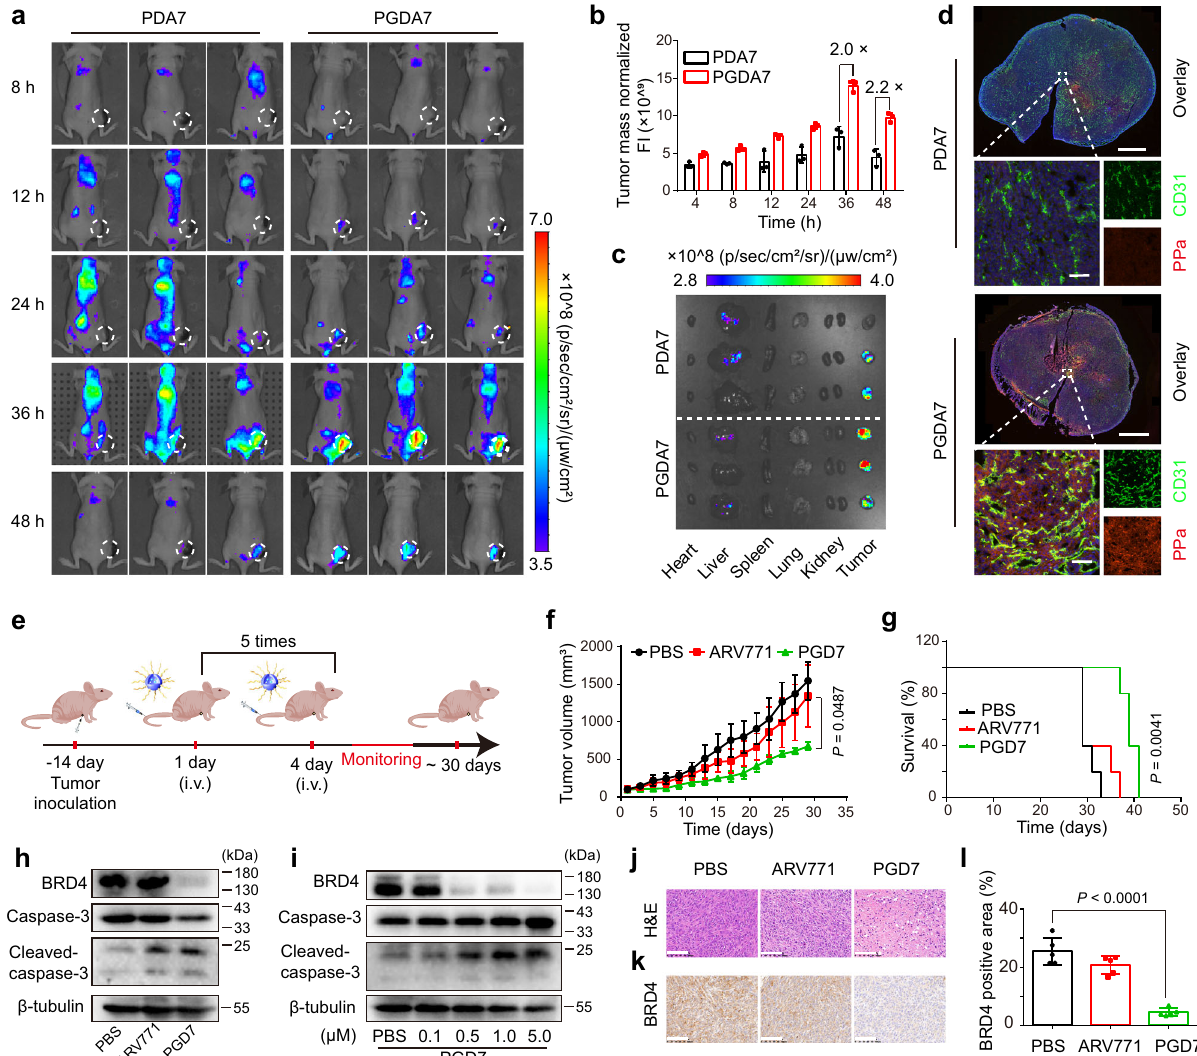
Fig. 4 | Stimuli-activatable POLY-PROTAC NPs speci fi cally accumulated at the tumour site and suppressed tumour growth in vivo. a Fluorescence images of POLY-PROTACNPsdistributioninMDA-MB-231tumour-bearingnudemiceinvivo. MMP-2-activatable PGDA7 NPs speci fi cally accumulated at the tumour site. b Normalised fl uorescence intensities of the tumour tissue ( n =3 biologically independentmice). c Exvivo fl uorescenceimagesof themajororgansand tumour (the major organs and tumours were harvested 48h post-injection). d Ex vivo CLSM images of tumour sections at 48h post-injection (top panel scale bar = 2.0mm, bottom panel scale bar = 50 μ m). e Treatment schedule of the POLY- PROTAC NPs antitumor study in MDA-MB-231 tumour-bearing nude mice. f, g PGD7 NPs ef fi ciently suppressed MDA-MB-231 tumour growth without notable adverseeffects. f Tumourgrowthcurvesand g survivalplotsofthetumour-bearing BALB/c nude mice upon POLY-PROTAC NPs treatment ( n =5 biologically